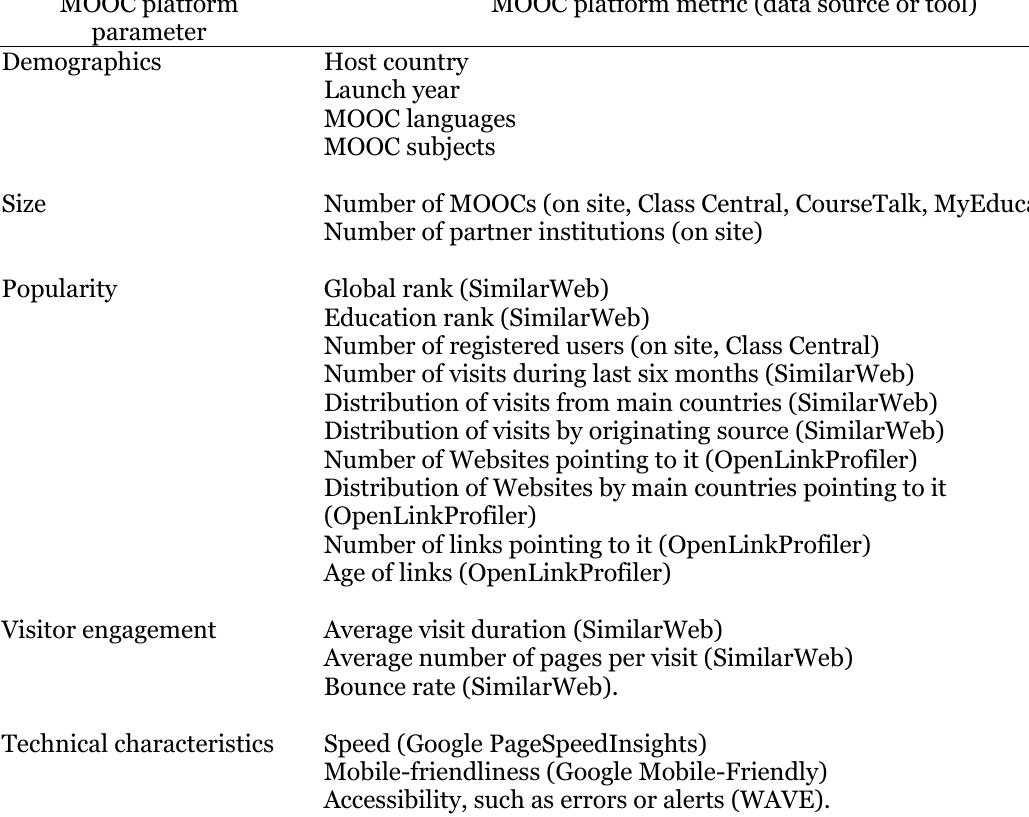
Table 2 Evaluation Parameters and Metrics for Measuring MOOC